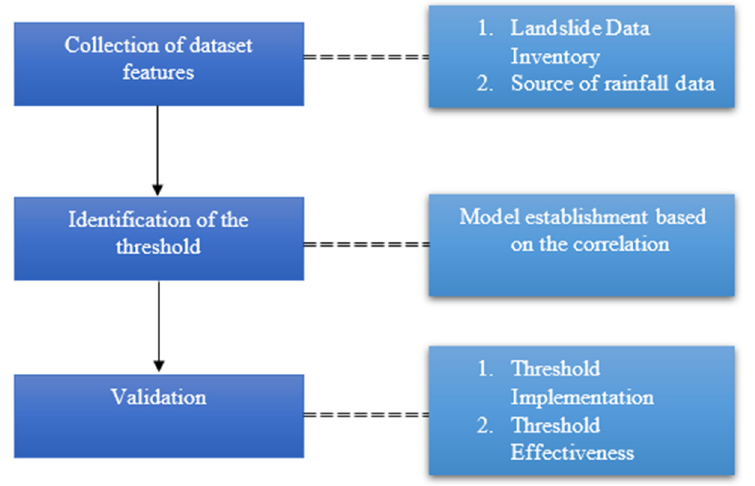
Figure 3. Rainfall threshold development process.